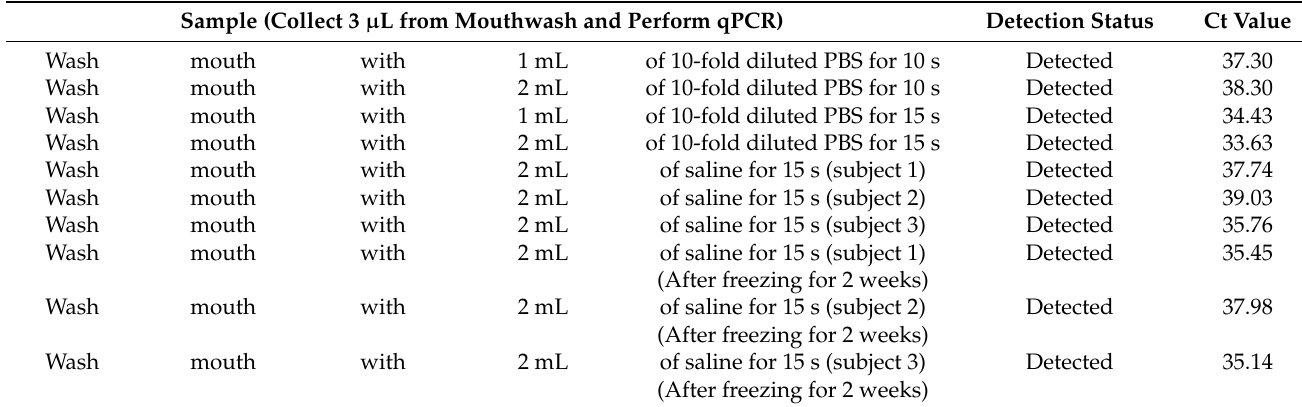
Table 5. qPCR results when mouthwash is used as a sample.